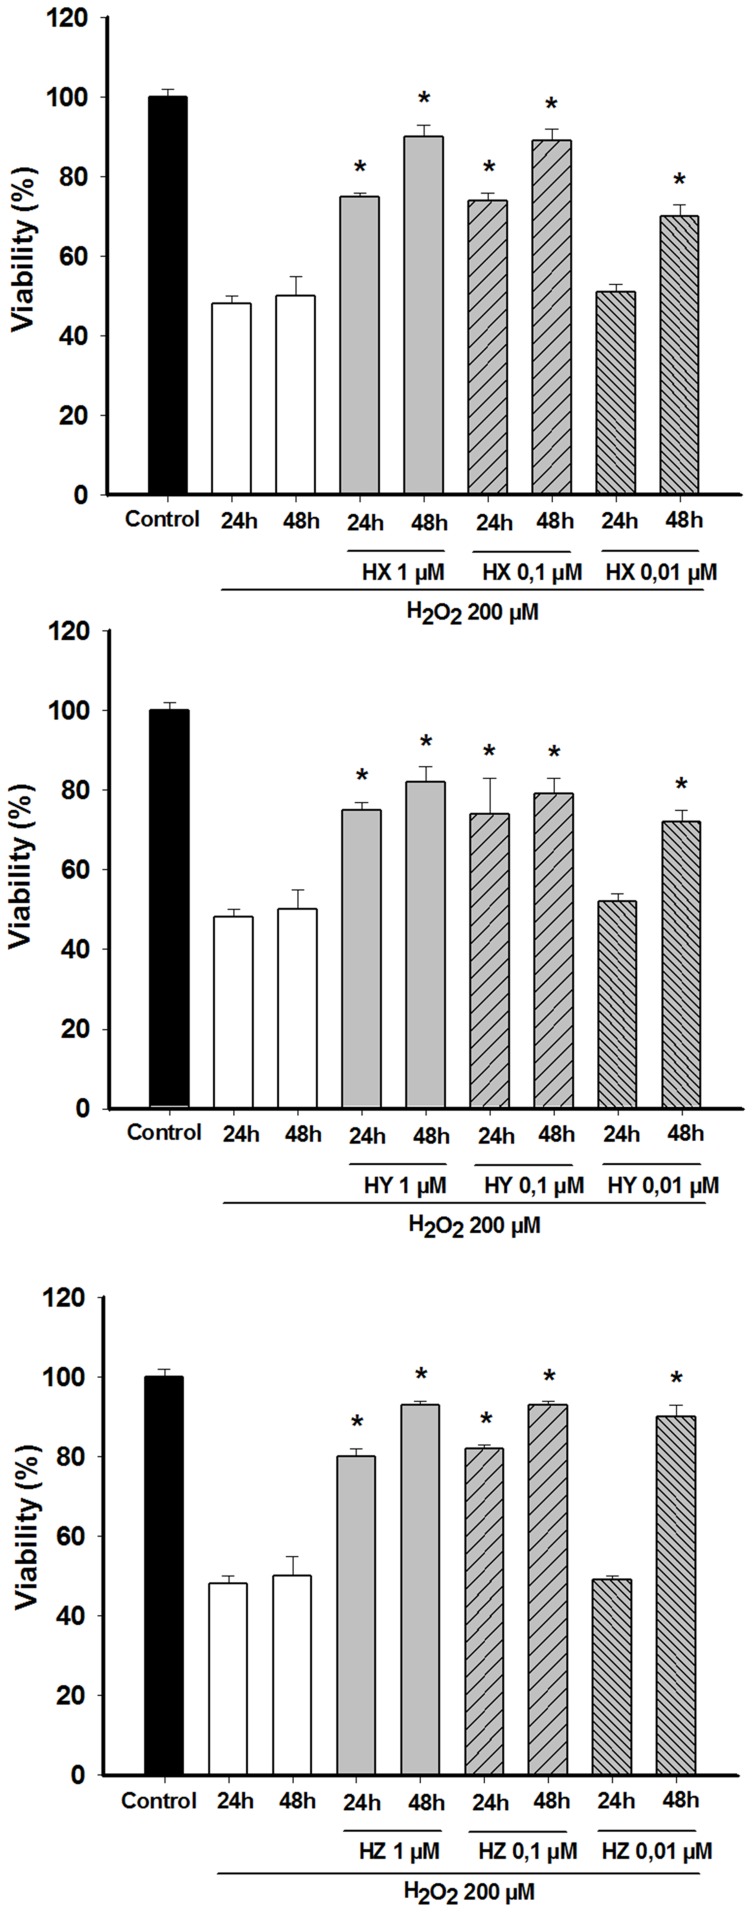
Attenuation of H2O2-induced cell damage by different concentrations (0.01 µM, 0.1 µM, 1 µM) of (A) HX, (B) HY and (C) HZ in undifferentiated PC12 cells.Cells were incubated with 200 µM H2O2 for 2 h. Huprines were added to the culture 24–48 h prior to H2O2 addition. Cell viability was assessed by measuring the MTT reduction. At least three independent experiments were carried out in triplicate. The data are means ± s.e.m. expressed as percentage of control value. *P<0.05 compared with H2O2 group (Dunnett's test).